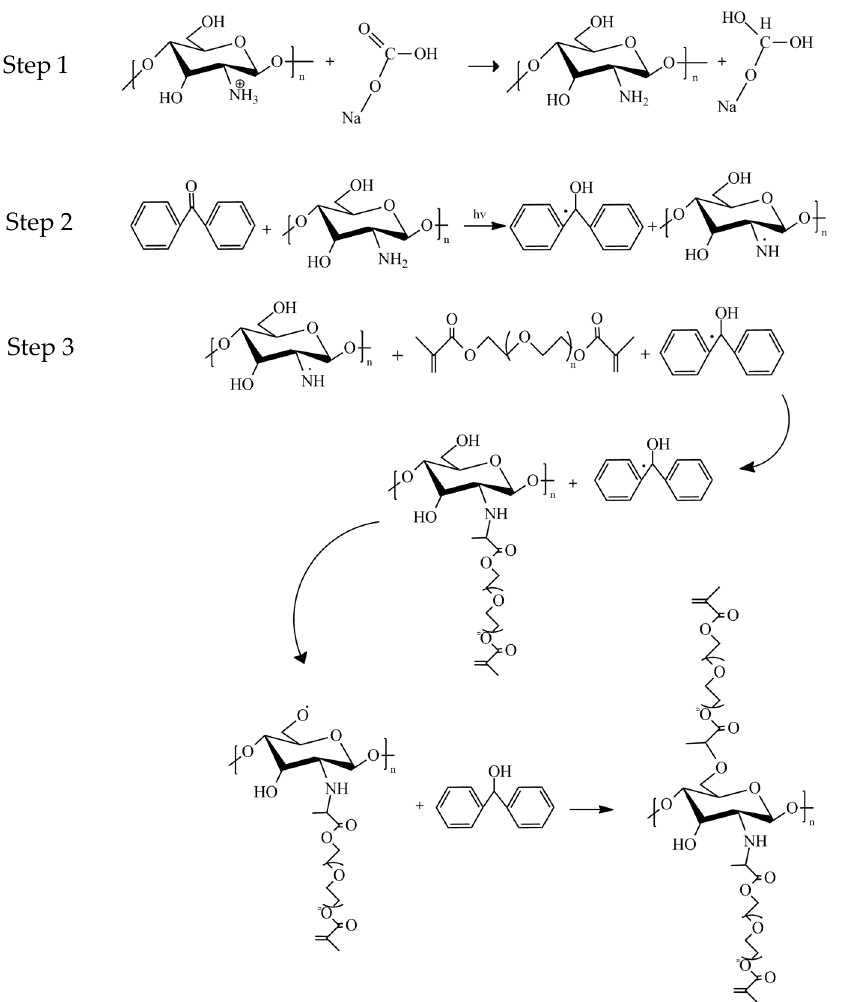
Figure 1. An extended photo crosslinking postulated. The protonated chitosan was neutralised with sodium bicarbonate solution (Step 1) and reacted in UV light in the presence of benzophenone producing a radical (Step 2). Further UV irradiation produces another available radical, leading to a stronger crosslinking (Step 3).